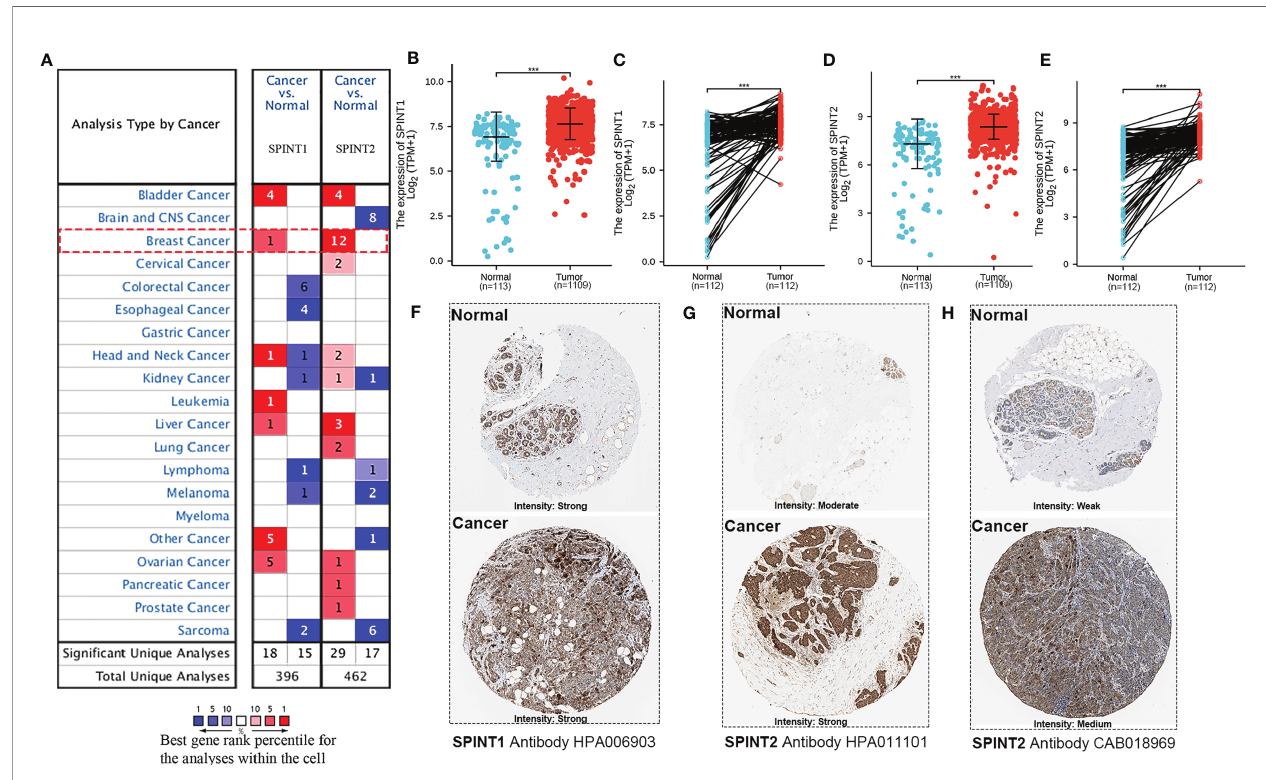
FIGURE 1 | SPINT1/2 were overexpressed in breast cancer. (A) datasets reporting the upregulated expression of SPINT1/2 in Oncomine. The differential expression of SPINT1 mRNA in non- (B) and paired (C) breast cancer tissues. The mRNA expression of SPINT2 in non- (D) and paired (E) breast cancer samples. The protein expression of SPINT1 (F) and SPINT2 (G, H) in normal and cancer tissues from HPA database. * P <.05; ** P <.01; *** P